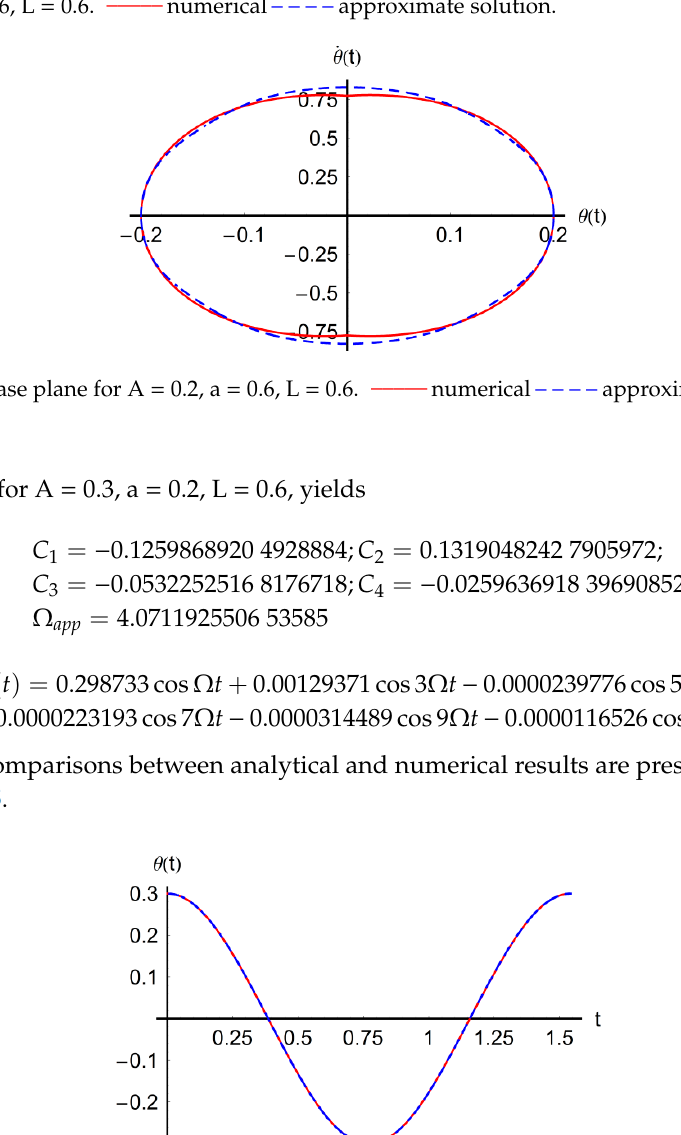
Figure 21. Phase plane for A = 0.4, L = 0.6. Figure 14. Comparison between the approximate solution (45) and numerical integration results for A = 0.3, a = 0.2, L = 0.6.